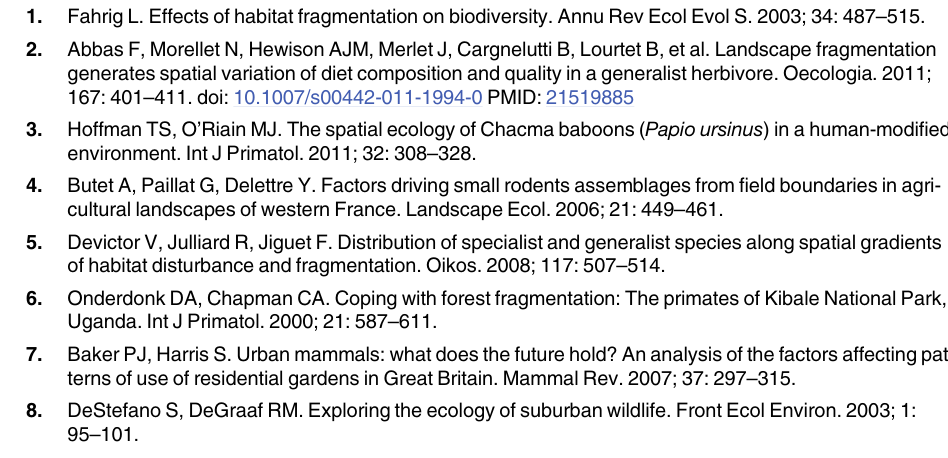
S1 Table. Mean annual and monthly variations in the diet of the peri-urban Barbary ma- caque group ‘ Les Oliviers ’ at Gouraya National Park (Algeria) and phenology of food items. S2 Table. Mean annual and monthly variations in the diet of the non-urban Barbary ma- caque group ‘ Cap Carbon ’ at Gouraya National Park (Algeria), and phenology of food items. S3 Table. Proportions of the monthly feeding times spent on 11 food categories by Barbary macaques from the three age-sex categories at the Cap Carbon (non-urban) and Les Oli- viers (peri-urban) sites. AM: adult male; AF: adult female; IM: